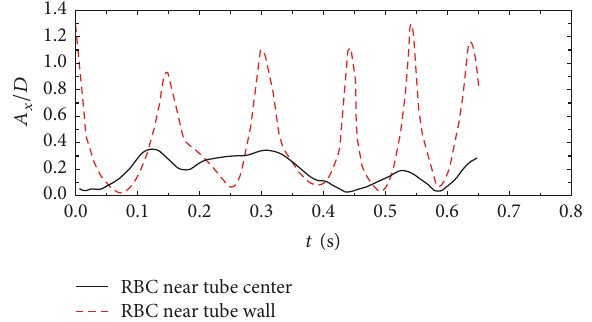
Figure 5: Time history of RBC orientation angle referring to the streamwise direction: 𝐴 𝑥 ( 𝐷 is the RBC